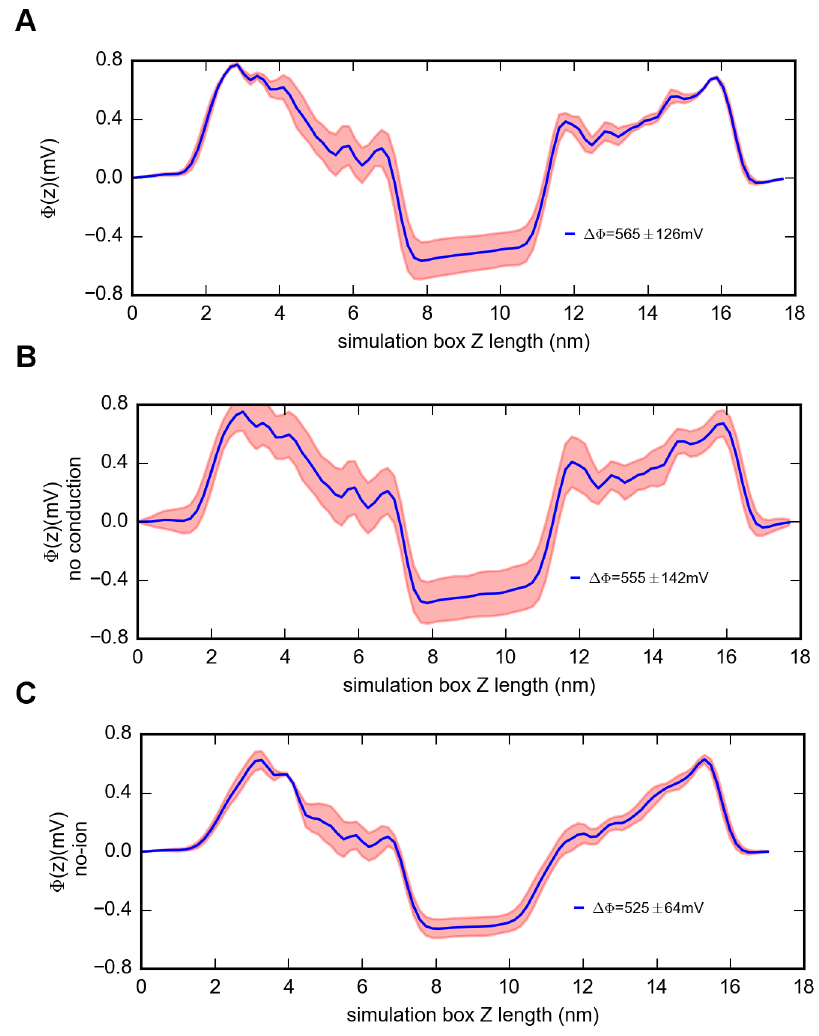
Figure 2. Transmembrane voltages comparison. A) Electrostatic potential across the simulation box calculated from the simulations without dihedral restraints on E53. B) Electrostatic potential across the simulation box calculated from the snapshots (t . 5 ns) extracted from the simulation in Figure 2A without ion conduction events in neither inward nor outward directions. C) Electrostatic potential across the simulation box calculated from the ‘‘no salt’’ simulations. (Error estimations shown in the figure are S.D.).